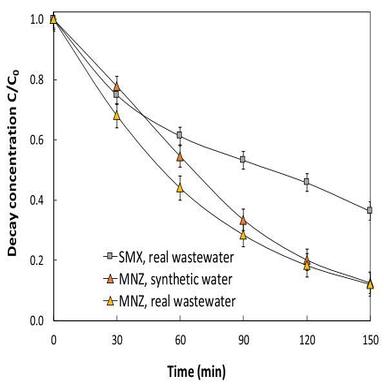
Decay concentration of metronidazole and sulfamethoxazole in real wastewater with heterogeneous EF using a CQ-cathode.